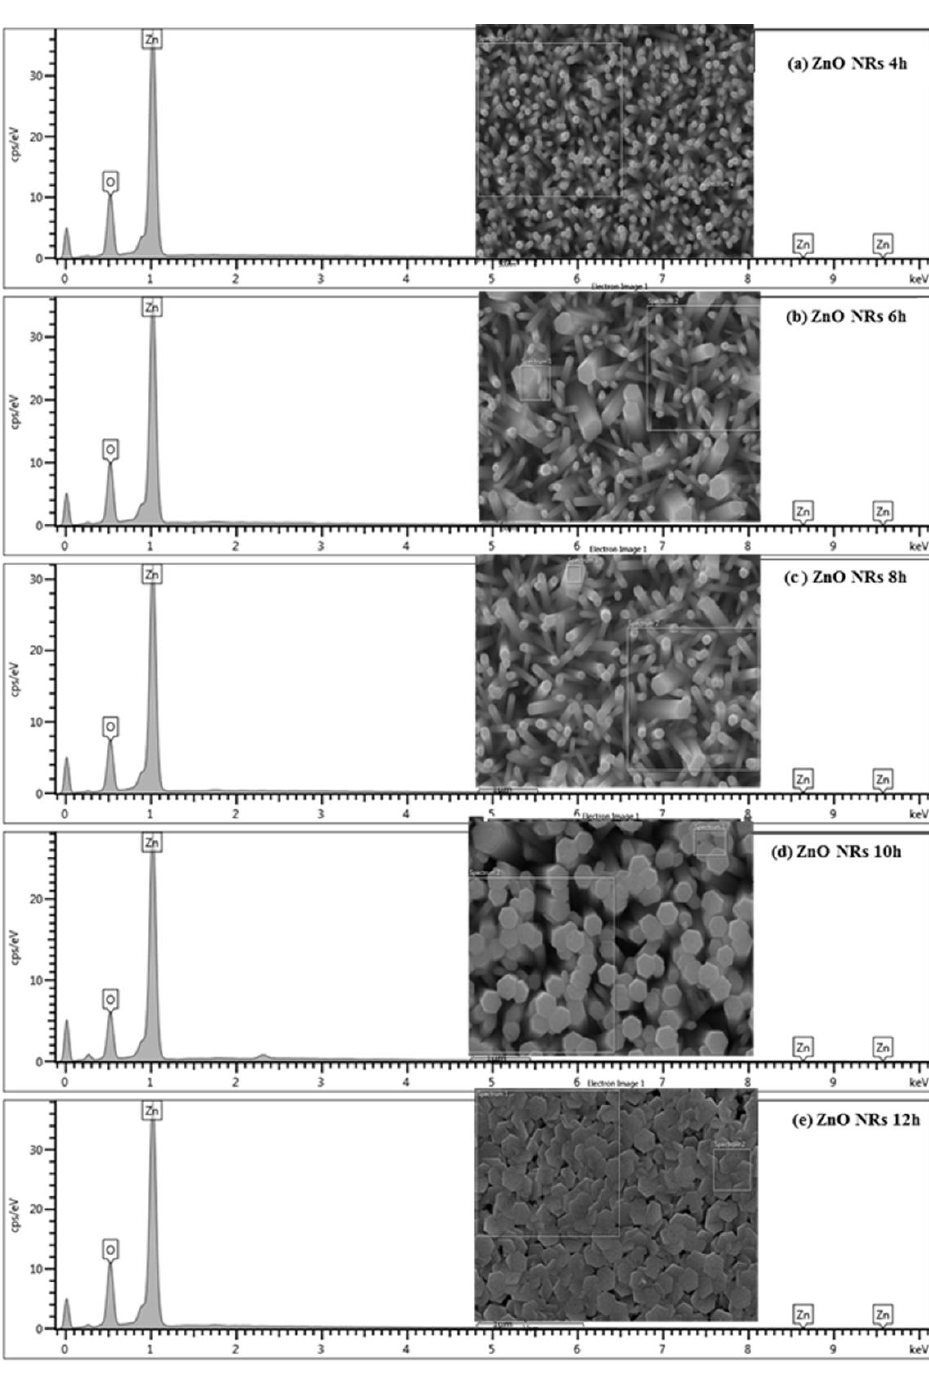
Figure 5. EDX spectra of ZNRAs prepared at various hydrothermal growth times with indicated scanned area in the FE-SEM image.